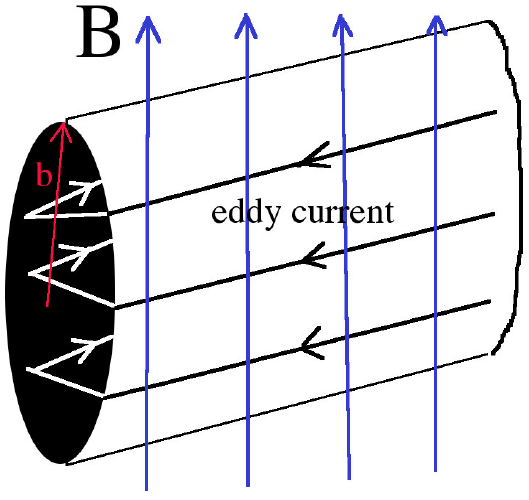
FIG. 2. (Color) The schematic picture of the eddy current, which flows in one of Cu stripes. For simplicity, it is assumed that the Cu stripe is cylindrical with its radius b . The external magnetic field B traverses the stripe vertically. Current lines couple to each other by the mutual inductance.